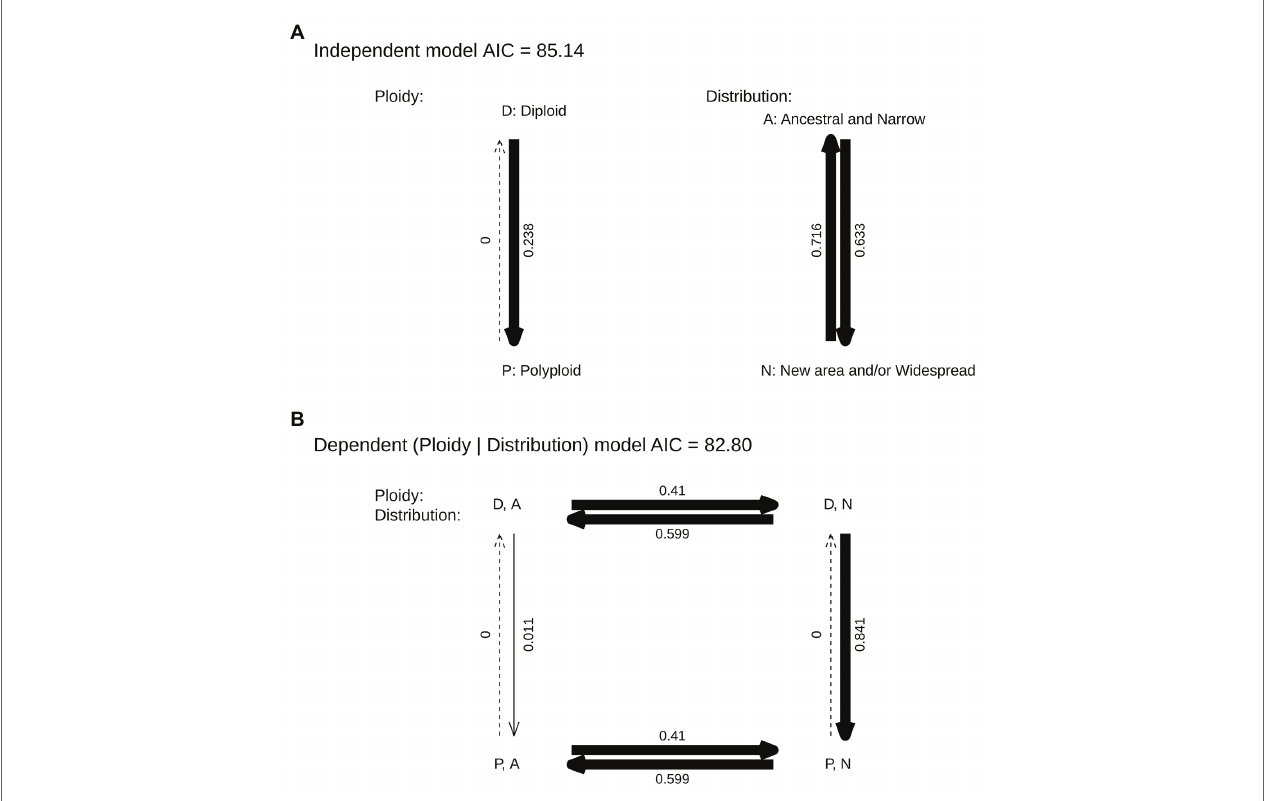
FIGURE 5 | Pagel’s binary correlation test of polyploidy (D for diploid, P for polyploid) and the presence in the area of origin of the species (A if the species is in the ancestral area, N if the species has colonized a new area even if it is still present in its ancestral area and/or have widespread distribution) in Centaurium . Independent (A) and dependent (B) models are shown. Arrow thickness indicates rate